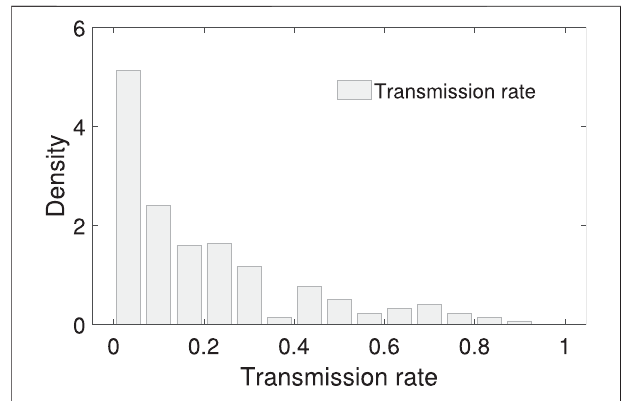
FIGURE4| Theempiricaldistributionofthetransmissionrate.Themean and median of the transmission rate is 0.20 and 0.13 with an interquantile range 0 – 0.3. No proper common distribution fi ts the empirical